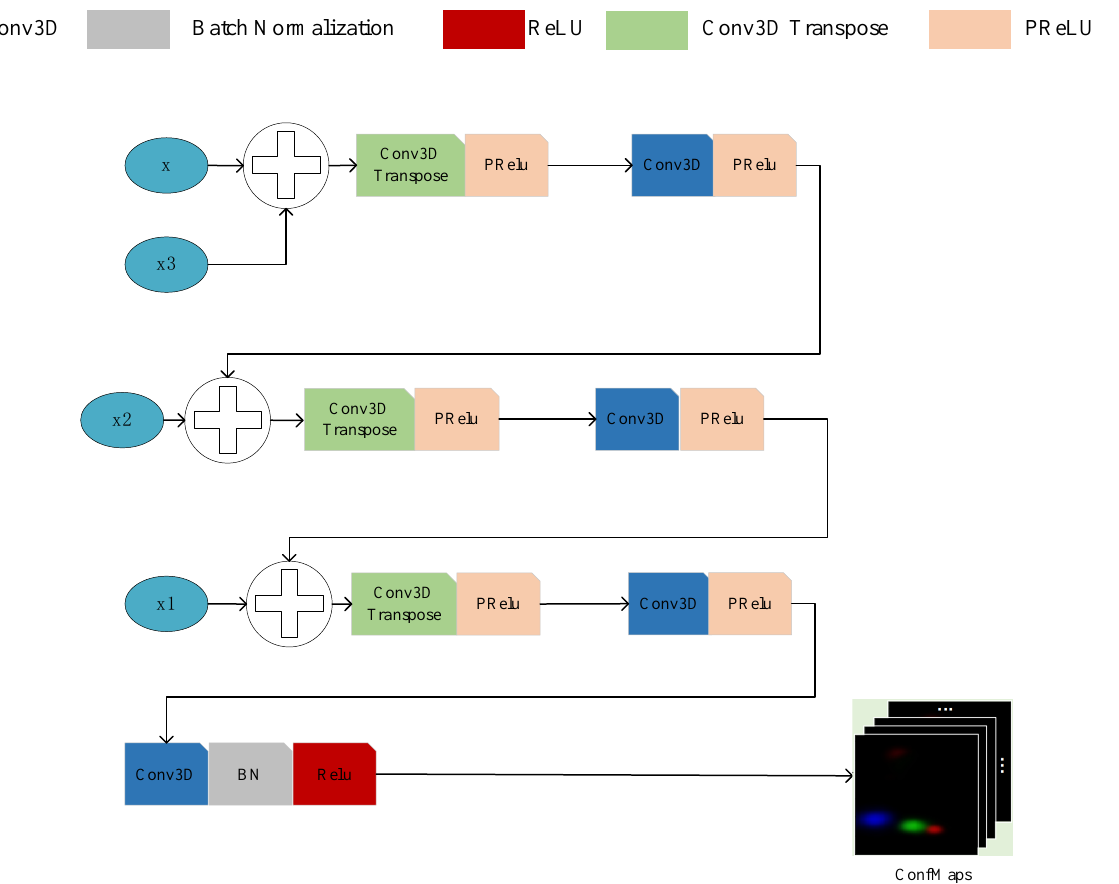
Figure 5. Hourglass three-dimensional convolutional neural network decoder with temporal incep- tion convolution layers.